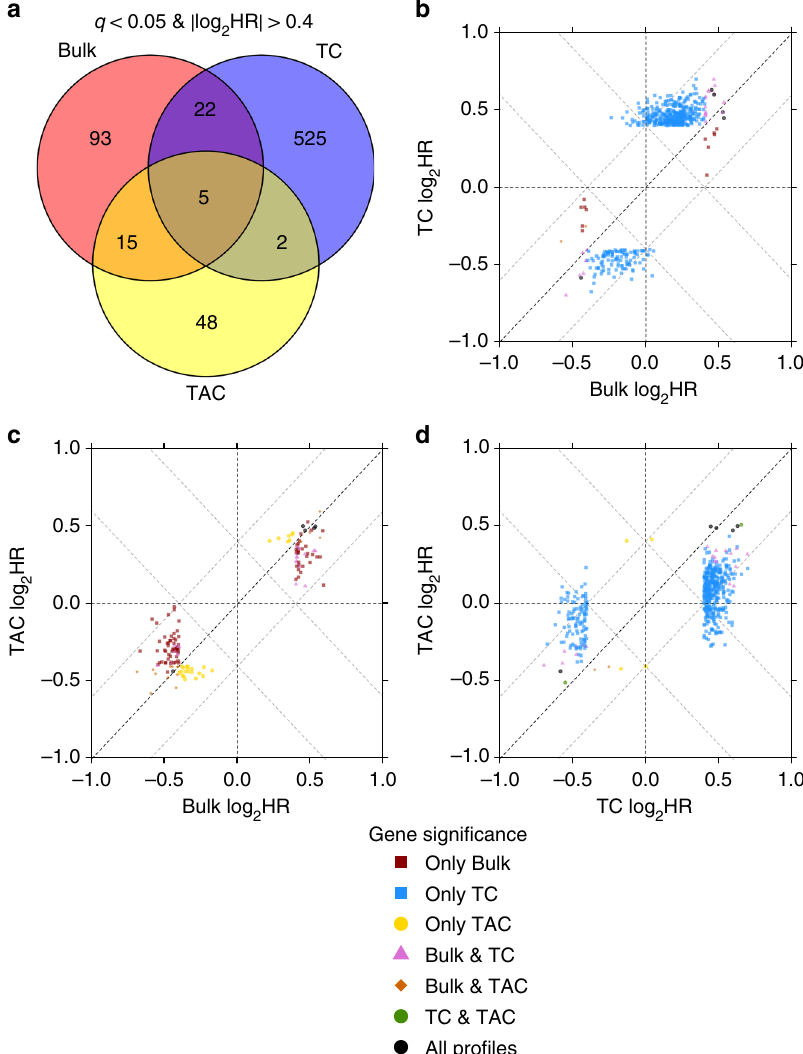
Fig. 3 Comparison of univariate prognostic results between pro fi les. The number of genes that are prognostic using a threshold of Wald q -value < 0.05 and |log 2 HR| > 0.4 a . The relationship between corresponding hazard ratios is shown in b – d . Points are coloured for which pro fi les they are signi fi cant in (colours follow similar colour mixing to the Venn diagram). b – d Dashed black lines show where the genes are not prognostic ( y = 0, x = 0) and where genes have equal prognosis in each pro fi les ( y = x ). Grey dashed lines indicate a difference of 0.4 between the log 2 HR from each pro fi le ( y = x − 0.4, y = x + 0.4, y = − x − 0.4, y = − x +